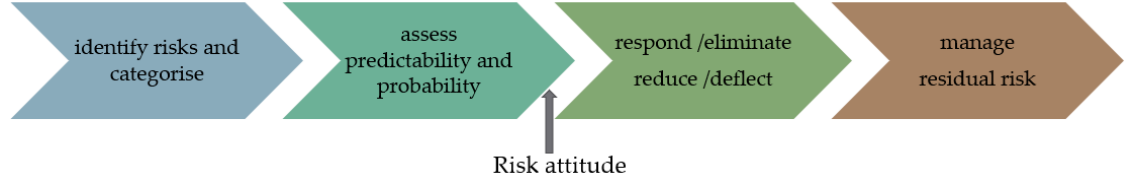
Figure 2. Logic workflow of the proposed strategy [20]. (Reproduced with permission from Mancini S., PhD thesis, 2018)